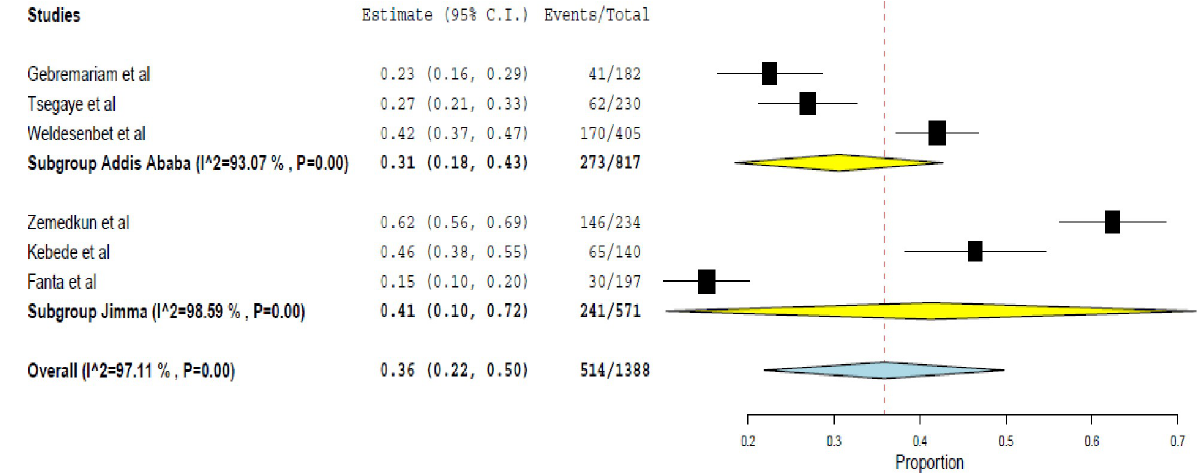
Fig 5. Rate of partly controlled asthma assessed using the GINA symptom